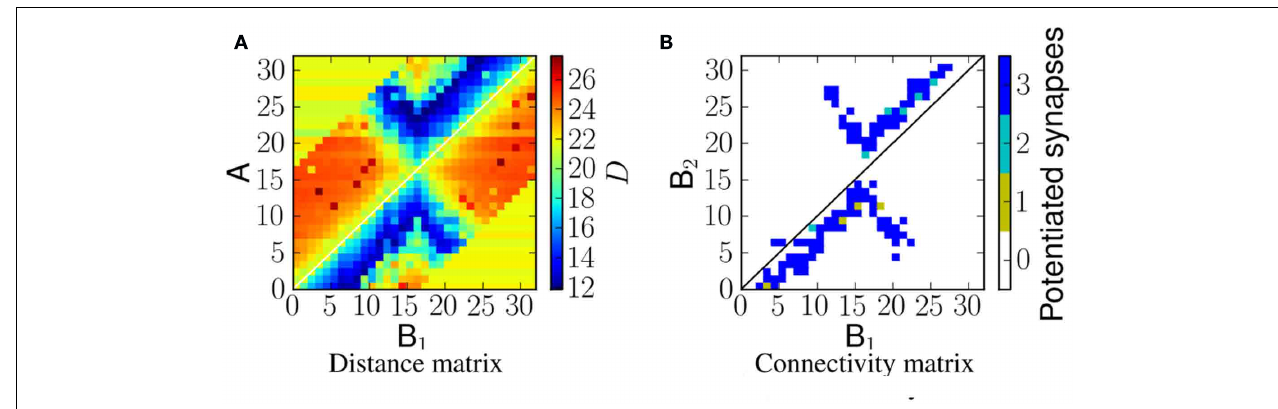
FIGURE 8 |A comparison of the distance D to the potentiated synapses, for a network exposed to a forked frequency sweep at velocity 1.0ms − 1 . (A) VRD between the spike trains from A neurons and B 1 neurons that reach B 2 neurons. (B) Number of potentiated synapses per projection from B 1 to B 2 neurons.